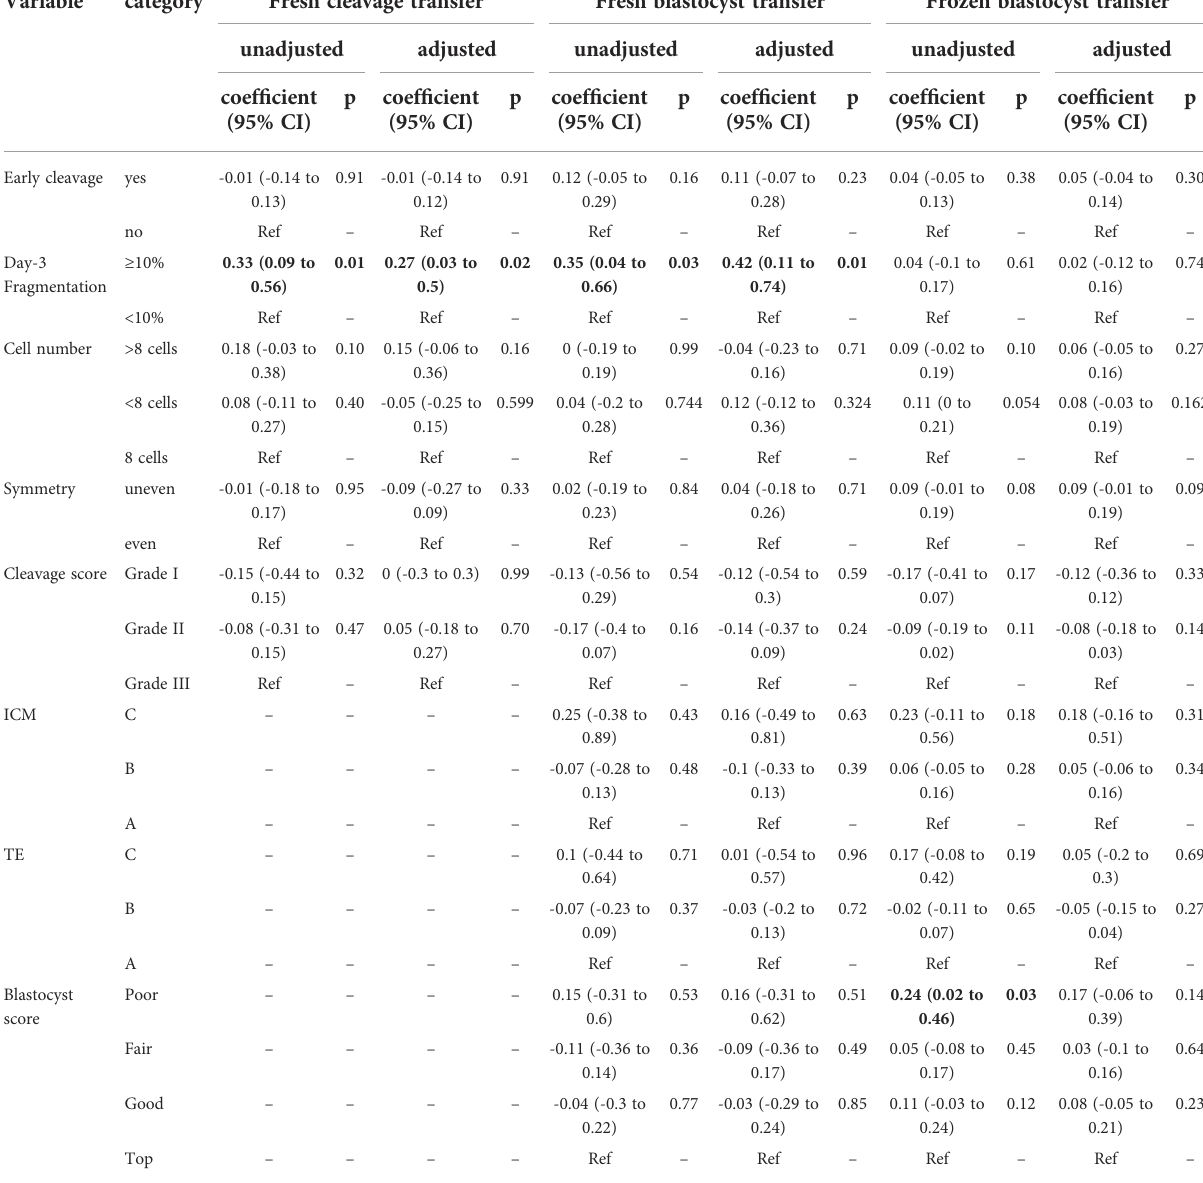
TABLE 2 Association between embryo morphological features and birth weight